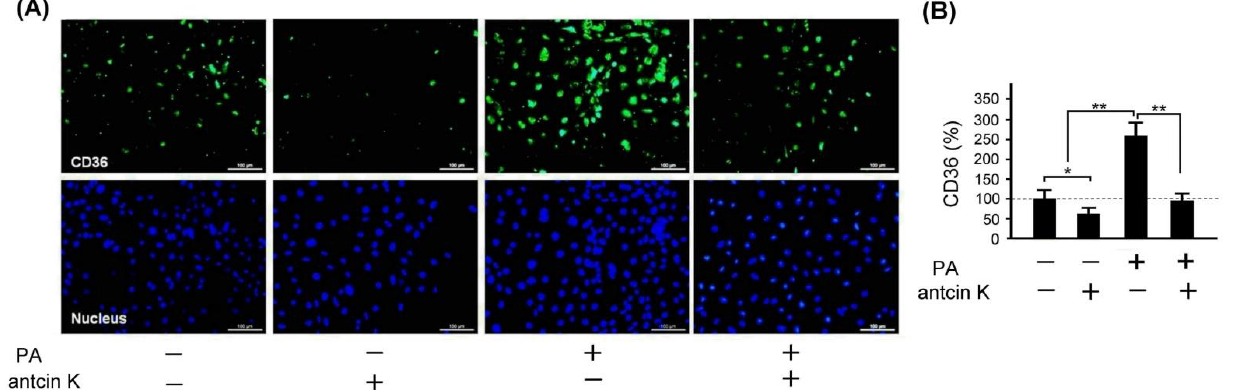
Figure 9. Antcin K treatments effectively reduced the expression of CD36 in palm oil-treated vascular endothelial cells. ( A ) Immunofluorescence staining to examine expressions of CD36 (green) and nuclei (blue, DAPI) in vascular endothelial cells with and without palm acid oil (PA) treatments, and with and without antcin K treatments. ( B ) Comparison of the quantified expression of CD36 of vascular endothelial cells with and without 0.75 mM palm acid oil (PA) treatment, and with and without 20 μ g/mL antcin K treatment ( n = 3 for each group; values are presented as mean ± SEM, * p < 0.05, ** p < 0.01, one-way ANOVA followed by the Student – Newman – Keuls multiple comparison post hoc test).